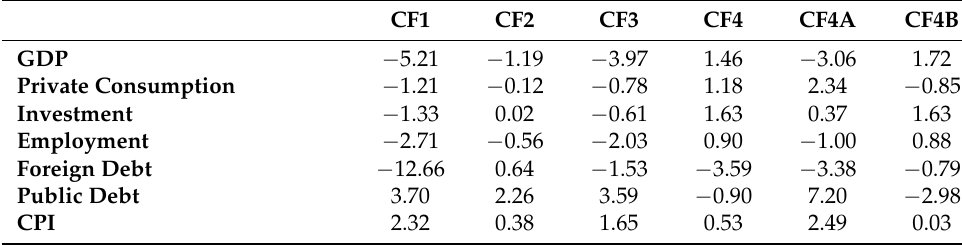
Table 5. Long run [2030] effects: macroeconomic performance.